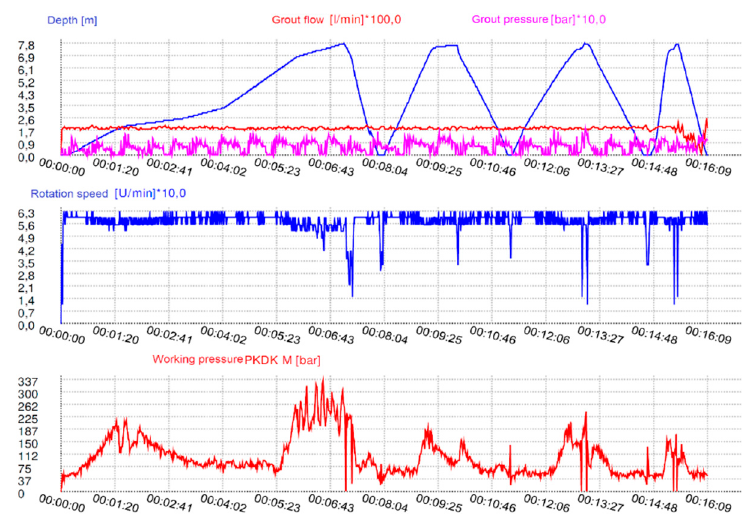
Figure 9. Parameters registered by the device during the formation of the 448 representative column. Geosciences 2020 , 10 , x FOR PEER